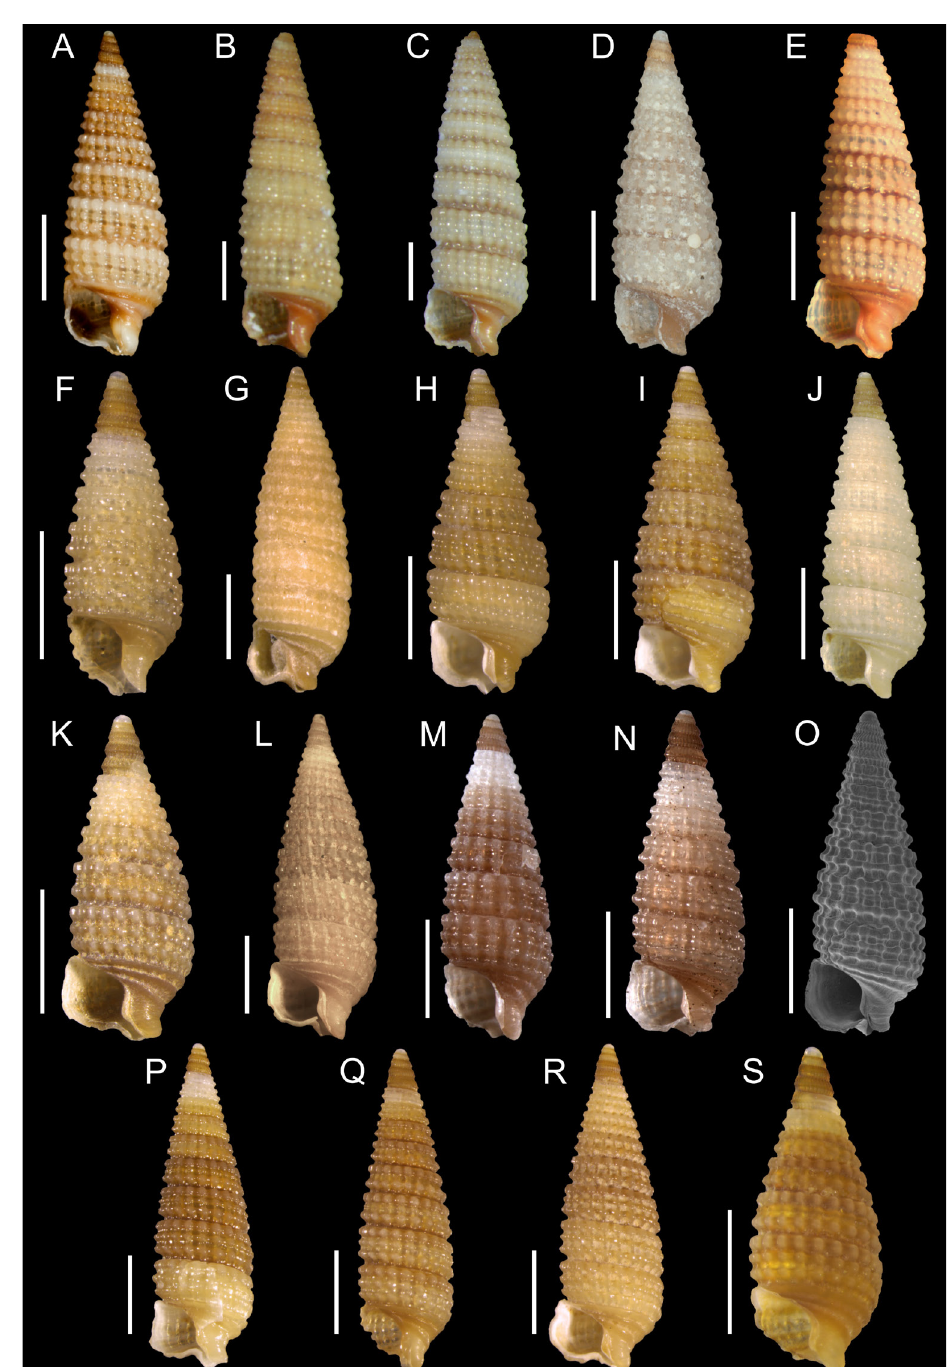
Fig. 7. Marshallora ostenta Rolán & Fernández-Garcés, 2008. A–E . From “Caribbean”. A . MNCN 15.05/47055, holotype, 4.20 mm. B–C . BMSM 15206, paratypes, 5.55 mm and 5.65 mm, respectively. D . USNM 1112660, paratype, 3.64 mm. E . FLMNH 419187, paratype, 3.71 mm. F–S . From Brazil. F . MNRJ 33801*, 2.42 mm. G . MORG 39090*, 4.00 mm. H–I . MNRJ 32412*, 3.03 mm and 3.07 mm, respectively. J . MNRJ 30750*, 3.61 mm. K . MNRJ 31017*, 2.50 mm. L . MNRJ 17227*, 4.40 mm. M . MNRJ 18588*, 3.34 mm. N–O . IBUFRJ 19532, 3.07 mm. P . MNRJ 31012*, 4.12 mm. Q . MNRJ 31087*, 3.91 mm. R . MNRJ 32659*, 3.91 mm. S . MNRJ 34026*, 2.65 mm. Scale bars: 1